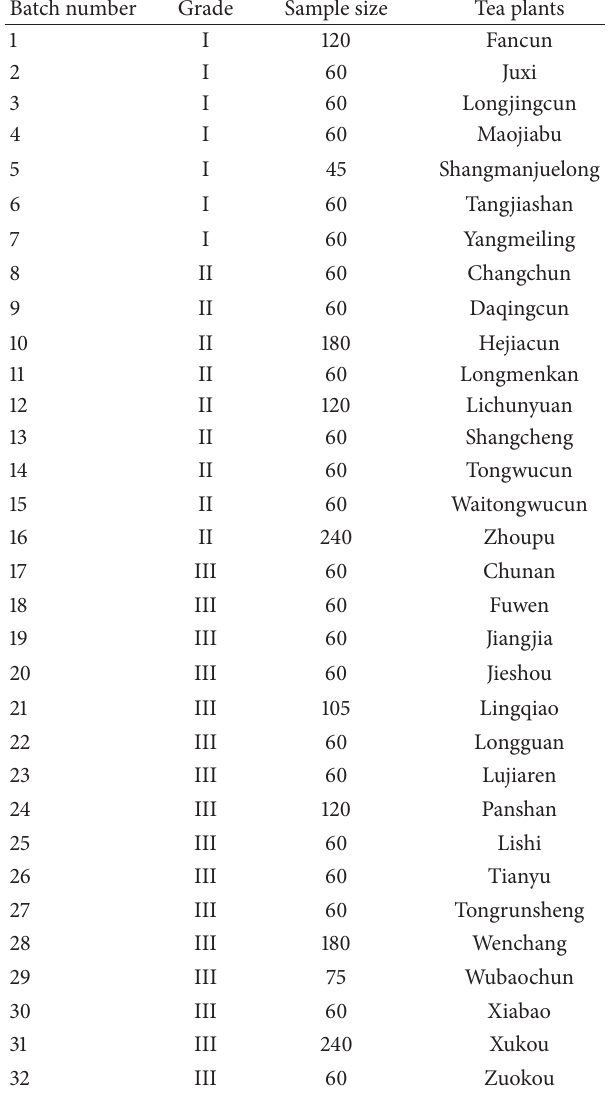
Table 1: Longjing tea of different